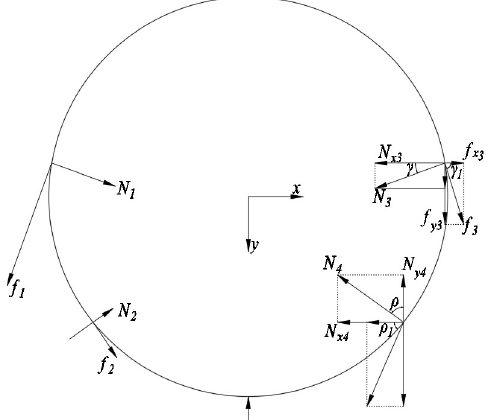
Figure 3. Schematic diagram of the forces on citrus. Note: f i is the static friction force in the vertical direction at the i-th contact point, N; N i is the positive pressure at the ith contact point, N; i = 1,2,3,4; mg is the gravity of the citrus fruit, N.